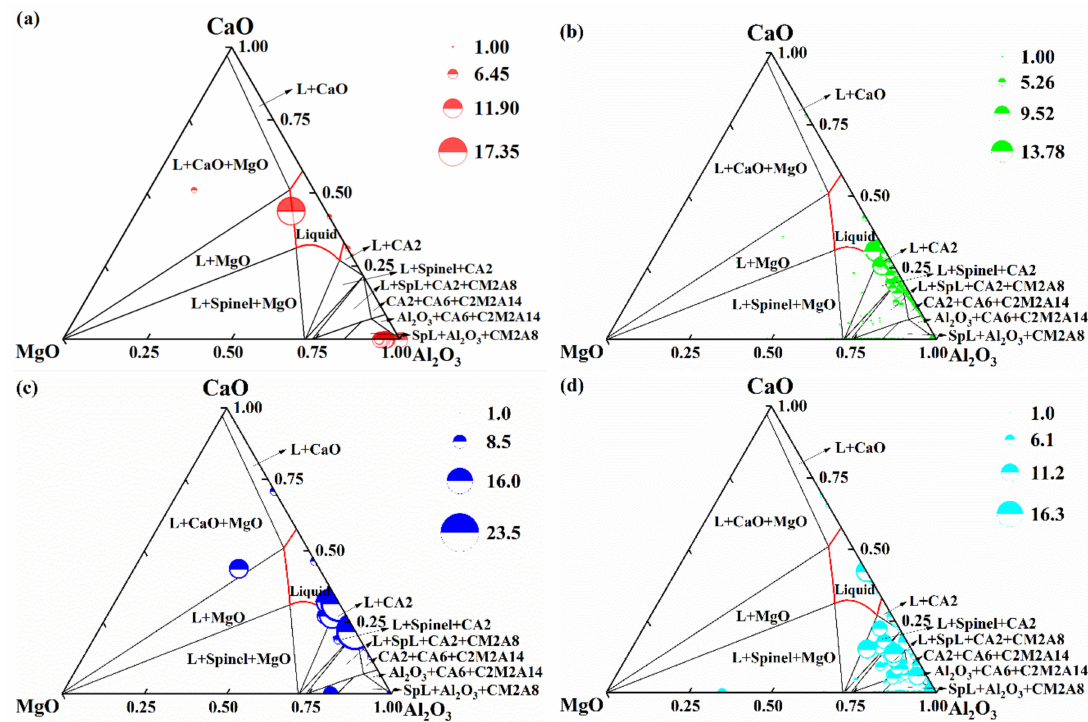
Figure 5. Main composition distribution of inclusions in different stages. ( a ) VD-end, ( b ) LF-end, ( c ) VC-onset, and ( d ) Casting.